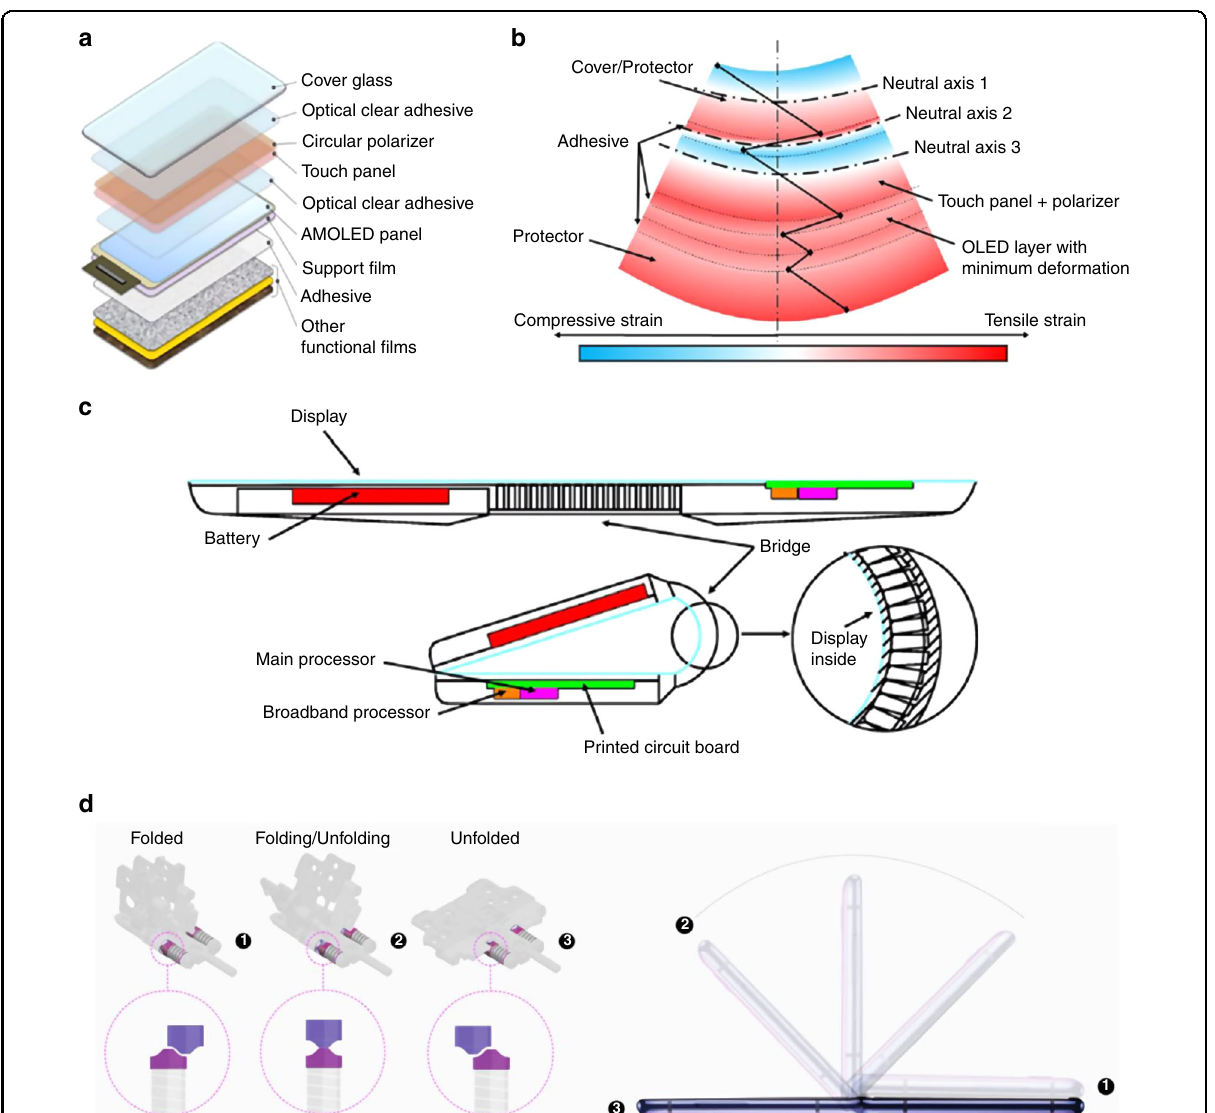
Fig. 4 Display structure of the display and hinge adopted in foldable displays. a Unit device layers in the foldable displays. Optimization of each layer and design of neutral planes determine the stress distribution applied to cover glass, polarizer, touch screen, and display panel